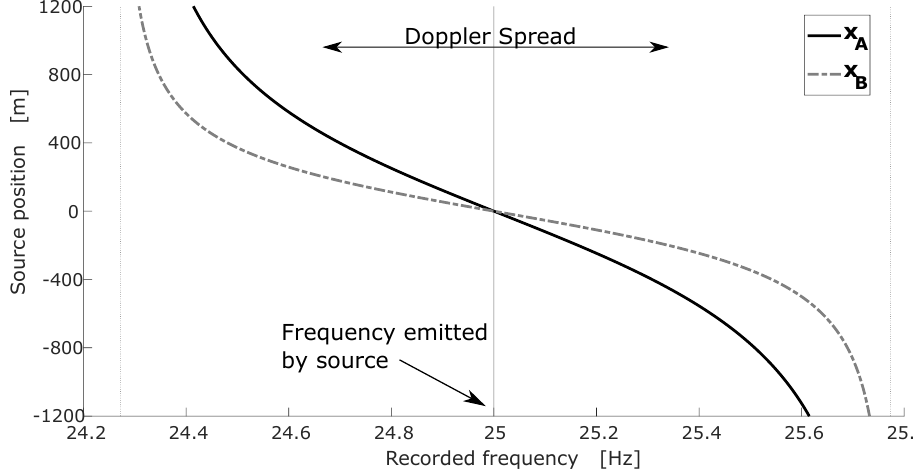
Figure 3. Relationship between source location and instantaneous frequency recorded at two different receiver locations x A , and x B . The simulated source was travelling at 30 m/s (108 km/h) and the medium speed was set at 1000m/s. For illustration purposes the source was set to be monochromatic, emitting noise at a fixed frequency of 25 Hz. The limiting values for the Doppler spread, given by 25/ ( 1 ± | v | / c ) Hz, are marked with vertical dotted